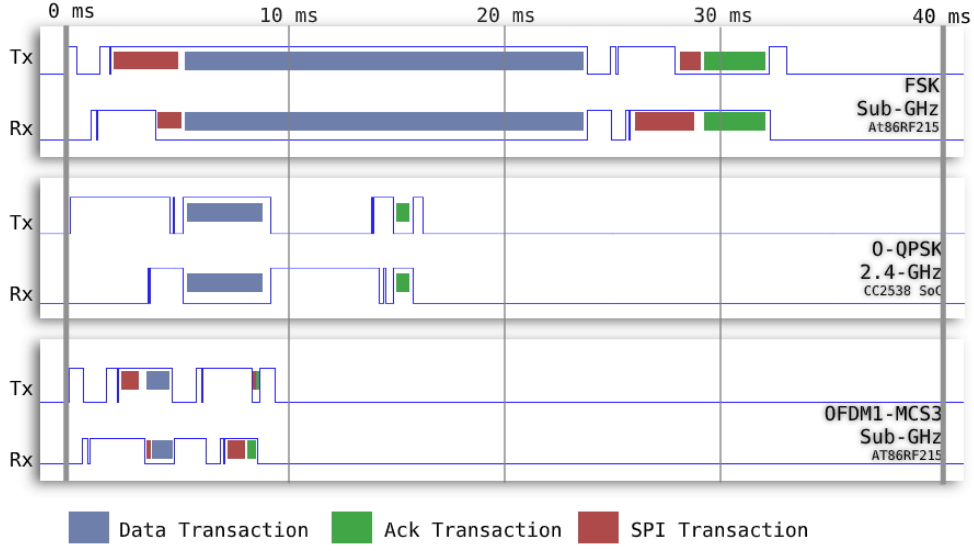
Figure 3. Logic analyzer capture of the custom timeslot templates for each PHY in accordance with the IEEE802.15.4e